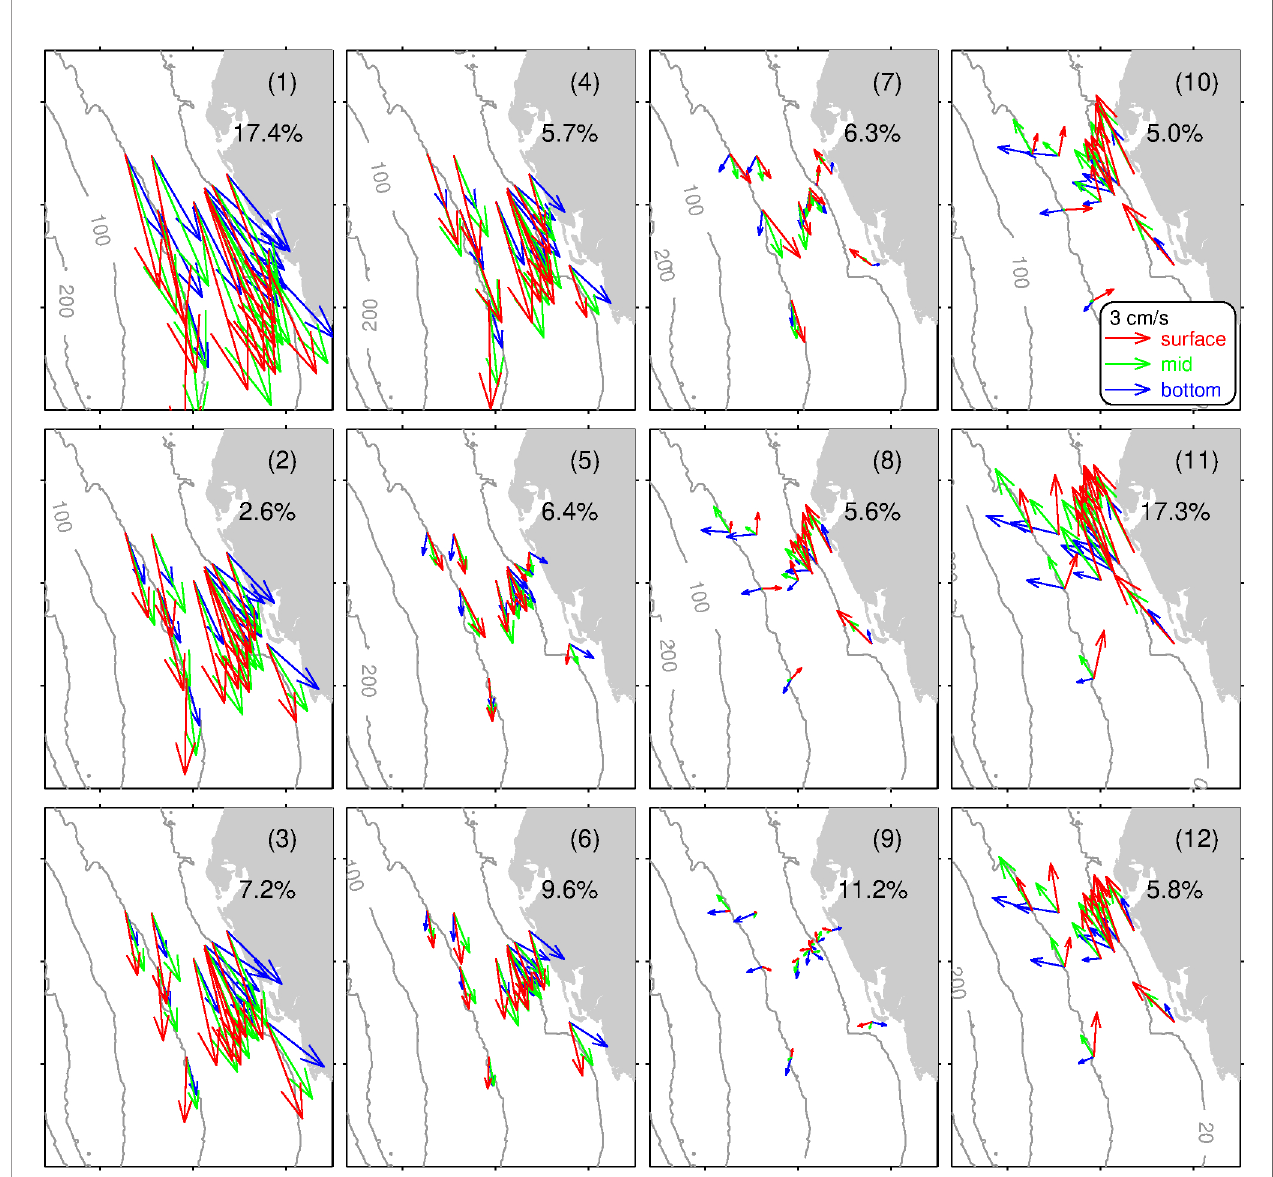
FIGURE 6 | A 3x4 Self Organizing Map array of velocity vector patterns spanning the inner-shelf. The input data set consisted of approximately three years of hourly 2-day low pass fi ltered velocity vectors sampled from near-surface (red), mid-water column (green) and near-bottom (blue) depths observed by ADCPs on a total of 11 moorings (from Liu and Weisberg, 2005a). The percentages provided in each pattern represents the percent of occurrence for each pattern. Note the systematic turning of the velocity vectors from near-surface to near-bottom, the asymmetry between upwelling and downwelling patterns, and, with the inner three isobaths (gray line) being 20 m, 50 m and 100 m depths, the largest vectors being located between the 20 m to 50 m isobaths and within this range, a little farther offshore for upwelling than for